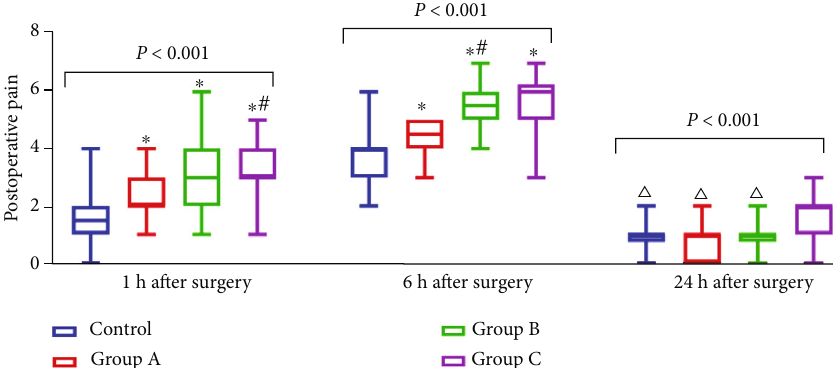
Figure 2: Comparison of postoperative pain ( n = 30 ). Note: compared with the control group, ∗ P < 0 : 05 ; compared with sleep disorder group A, # P < 0 : 05 ; compared with sleep disorder group C, △ P < 0 : 05 .